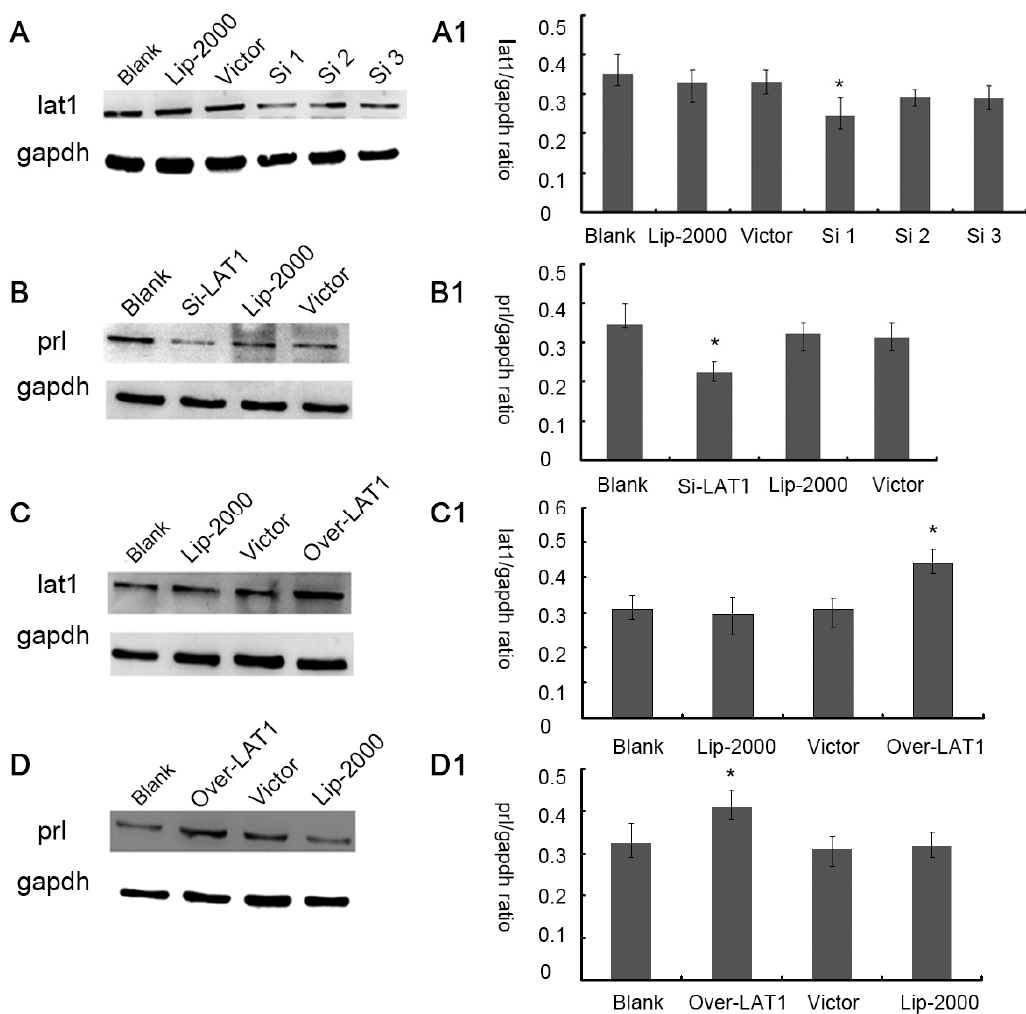
Figure 3. Regulations of lat1 Effect prl Expression in decidualization of ESC: ( A , A1 ) Confirmation of lat1 lower expression using Western blot analysis. Three sequences ShRNA called Si1, Si2, and Si3 were used in transfecting combined with 2000 transfection reagent (lip2000) and verify the Si1 sequence can effectively silent lat1; ( B , B1 ) Transfected with lat1shRNA, showing the lower expression of prl by Western blot analysis; ( C , C1 ) Confirmation of lat1 over expression after transfecting with pEGFP-N1- Lat1 plasmid (Over-lat1) using Western blot analysis; ( D , D1 ) Transfected with pEGFP-N1- Lat1 (Over-lat1) showing higher expression of prl by Western blot analysis. * p < 0.05, as compared with blank. There were 40 mice sacrificed in this